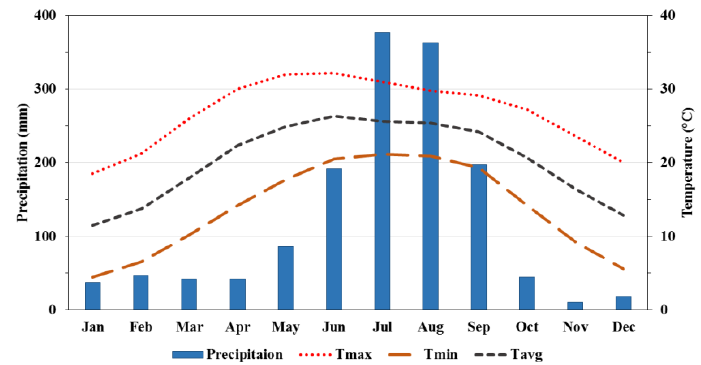
Figure 3. Average monthly precipitation and temperature (minimum, maximum, and average) in the KRB from 1981 to 2012.